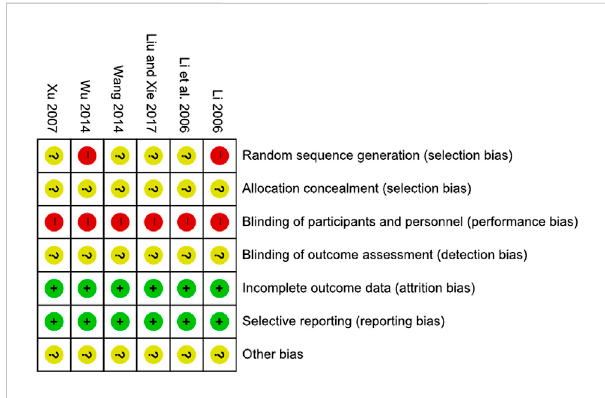
FIGURE 2 Summary of the risk of bias for each included study.